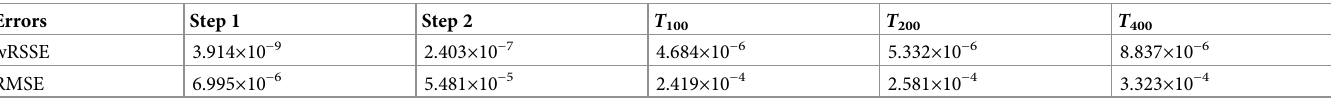
Table 1. Error indexes of k , k in modeling unbuffered gene network. The wRSSE and RMSE indexes are selected to judge the performance of parameter estimation. on off The title Step i ( i = 1, 2) represent the single and double inputs with the same concentration 20 μM . The columns T 100 , T 200 , T 400 denote the periodic inputs with periods T 1 = 100min, T 2 = 200min and T 4 = 400min.